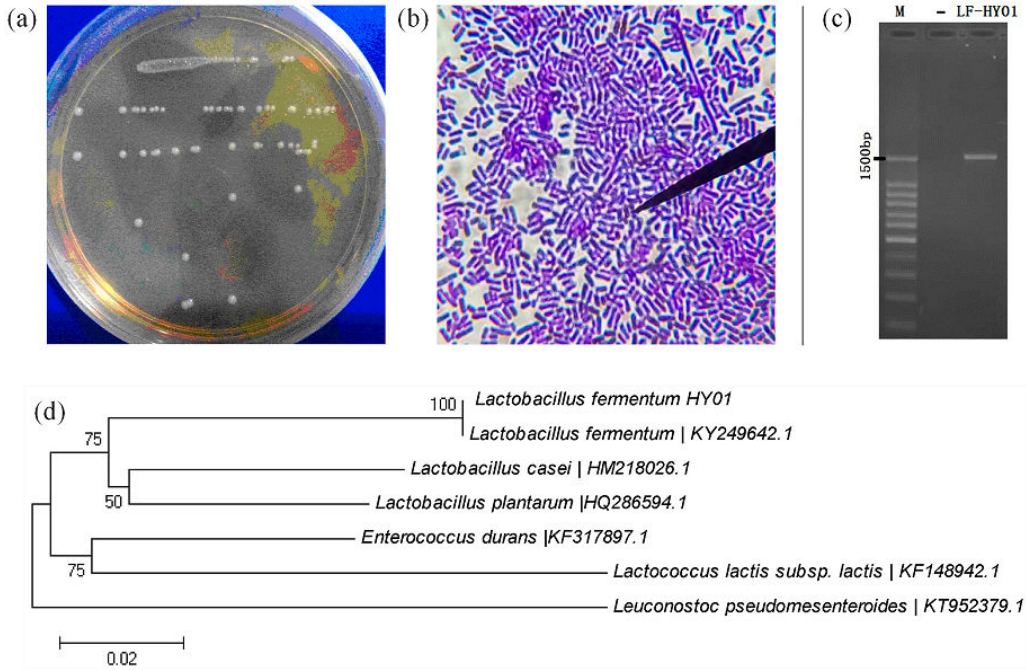
Figure 1. Isolation and identification of LF-HY01. ( a ) Colonial morphology of LF-HY01; ( b ) Cells form of LF-HY01; ( c ) Agarose gel electrophoresis of LF-HY01 16s rDNA PCR amplification product; ( d ) Phylogenetic analysis of LF-HY01.